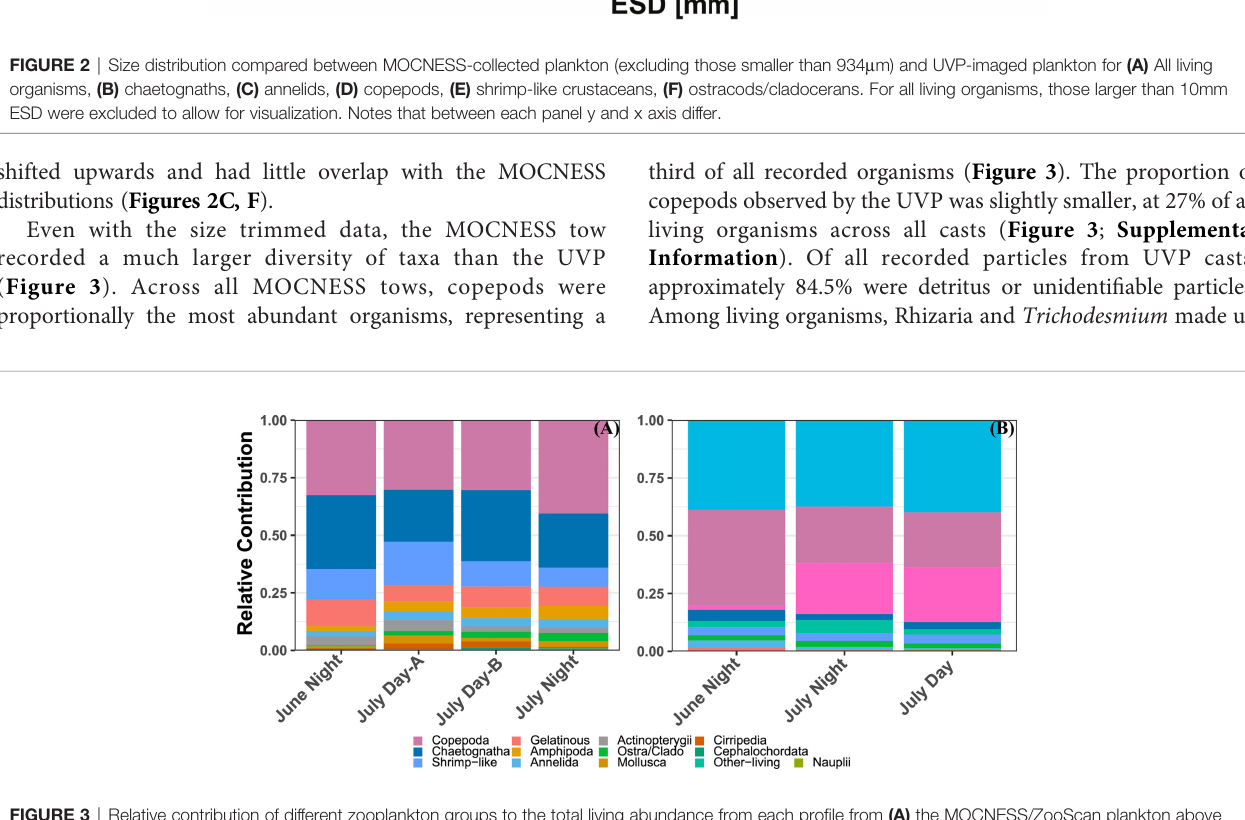
FIGURE 3 | Relative contribution of different zooplankton groups to the total living abundance from each pro fi le from (A) the MOCNESS/ZooScan plankton above the 934 m m size cut-off and (B) the UVP.